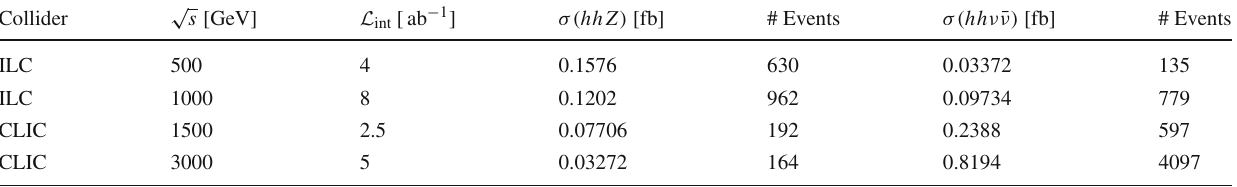
√ Table 3 Anticipated center-of-mass energies, s , corresponding integrated luminosities, L int , at ILC and CLIC and predicted cross sections and number of events for the di-Higgs production in the SM √ s [GeV] L int [ ab − 1 ] Collider